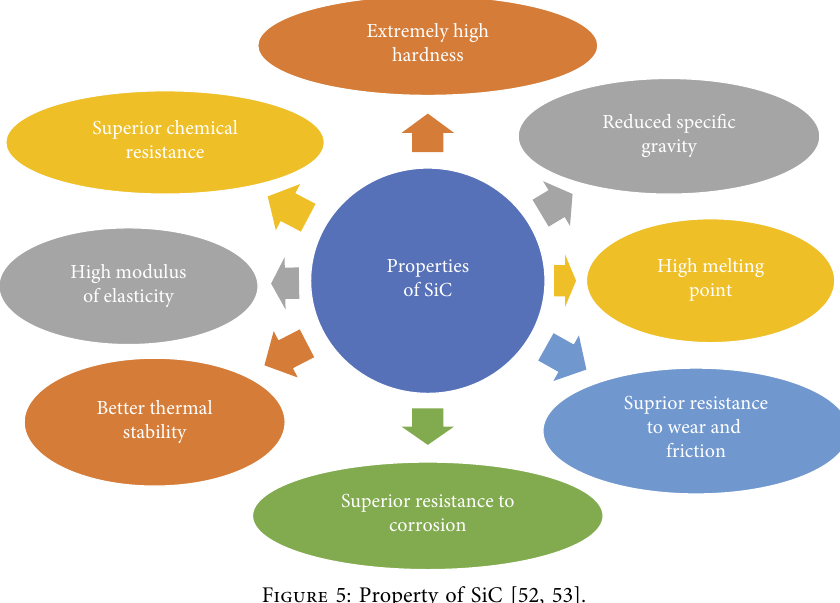
Figure 5: Property of SiC [52, 53]. Table 3: Comparison of monolithic and single and hybrid reinforced aluminum matrix composites [1, 5, 35, 55–60]. Properties